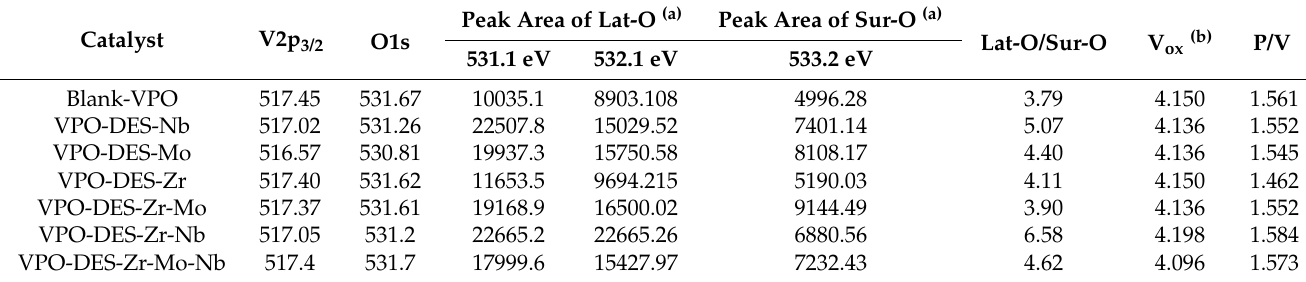
Figure 16. The V2p 3/2 fitting curve ( a ) and O1s fitting curve ( b ) of VPO catalysts prepared from monometallic, bimetallic and trimetallic DES. Table 3. The XPS characterization data of V2p 3/2 and O1s of Zr-, Nb-, Mo- DES-VPO catalyst are described as